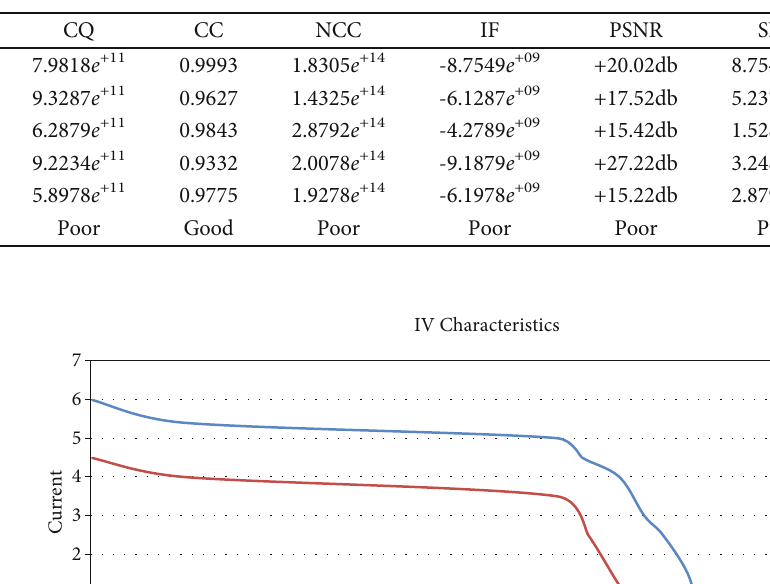
Table 2: Conventional metric indices.